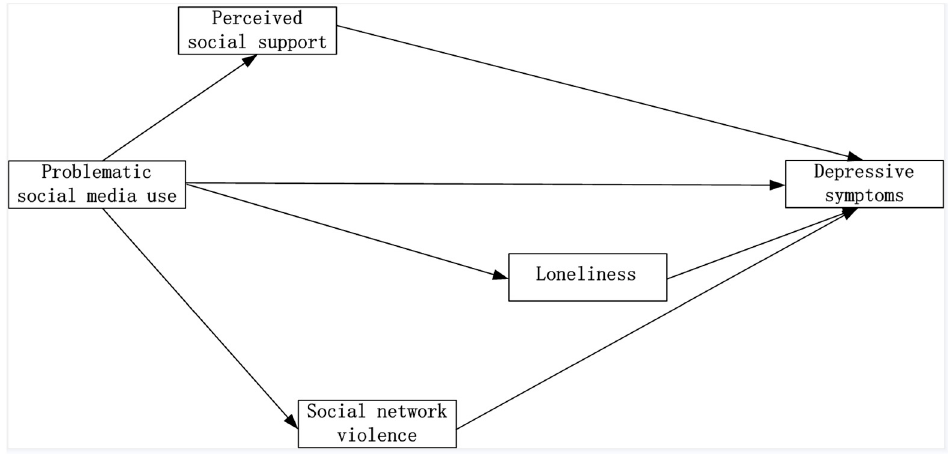
Figure 1. The conceptual model for Study